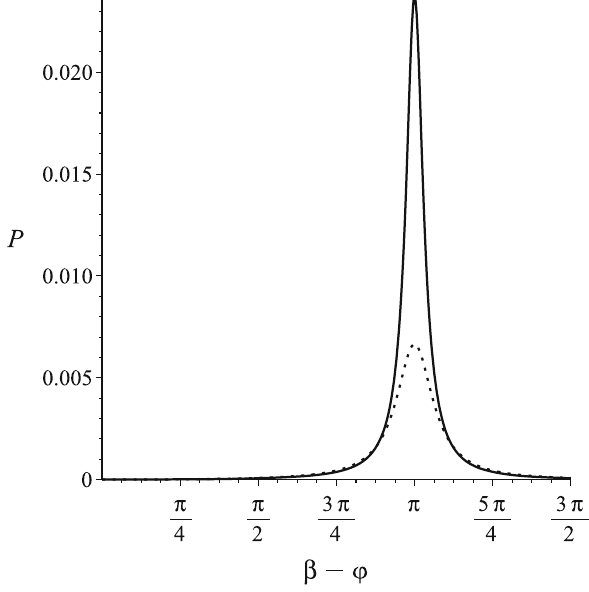
Fig. 5 P as a function of β − ϕ for for p / p (cid:8) = 0 . 9 solid line and p / p (cid:8) = 0 . 8 the point line. Parameter k = 1 . 52